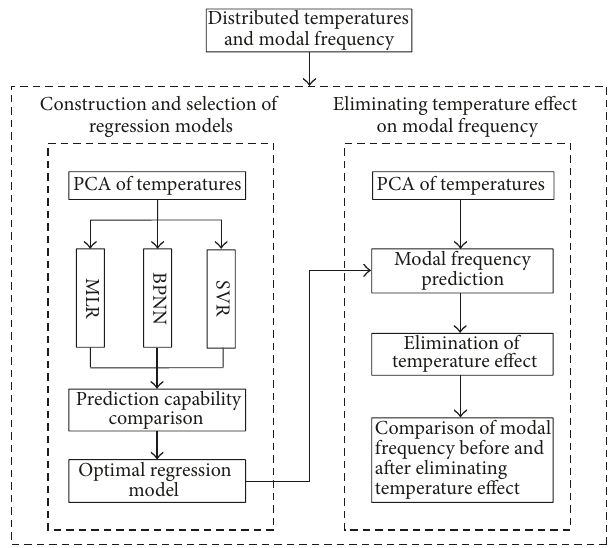
Figure 1: Technical flowchart of proposed method in this